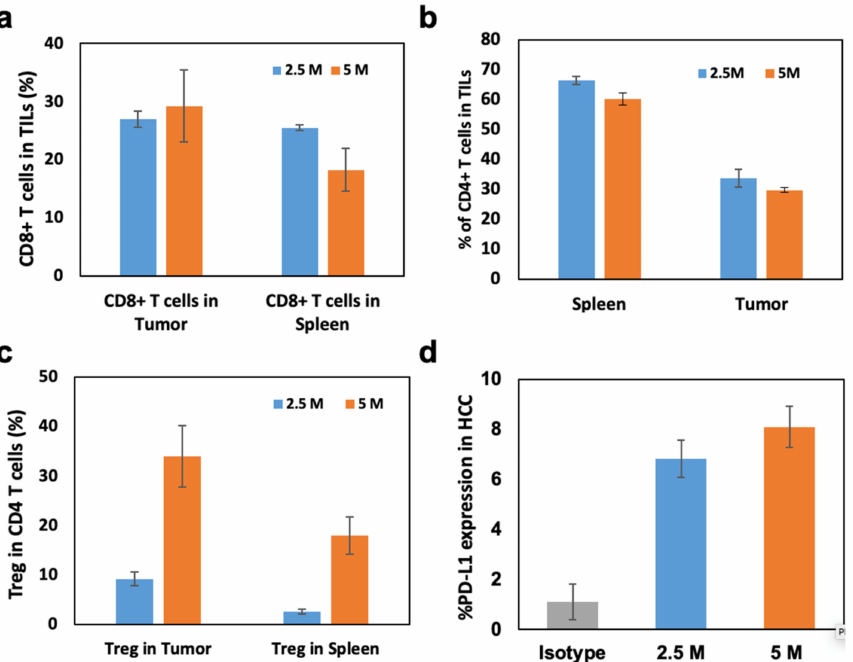
Figure 3. ( a ) CD8+ T cells, ( b ) CD4+ T cells, and ( c ) regulatory T cells (Tregs) in tumor infiltrated lymphocytes (TILs) of N1-S1 HCC tumors with 2.5 and 5 million N1-S1 cell implantations. ( d ) PD-L1 expression levels of N1-S1 HCC tumors generated with 2.5 or 5 million N1-S1 cells-implanted rats and isotype